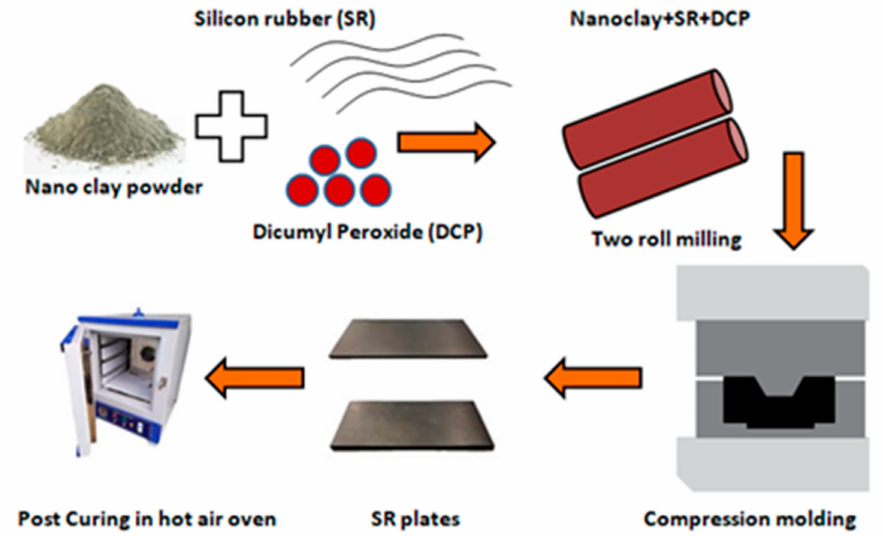
Figure 1. Schematic representation of SR–MMT manufacturing